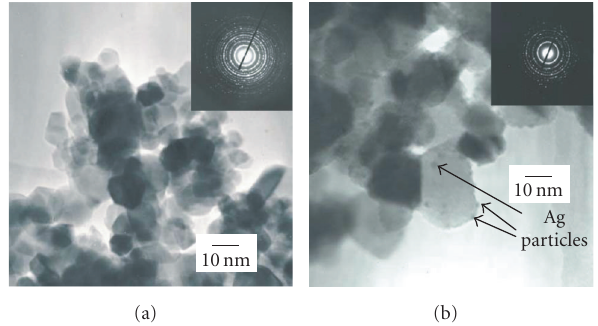
Figure 2: TEM micrographs and their corresponding selected area electron di ff raction patterns for 1wt.% Ag-TiO 2 calcined at (a) 450 ◦ C and (b) 600 ◦ C.